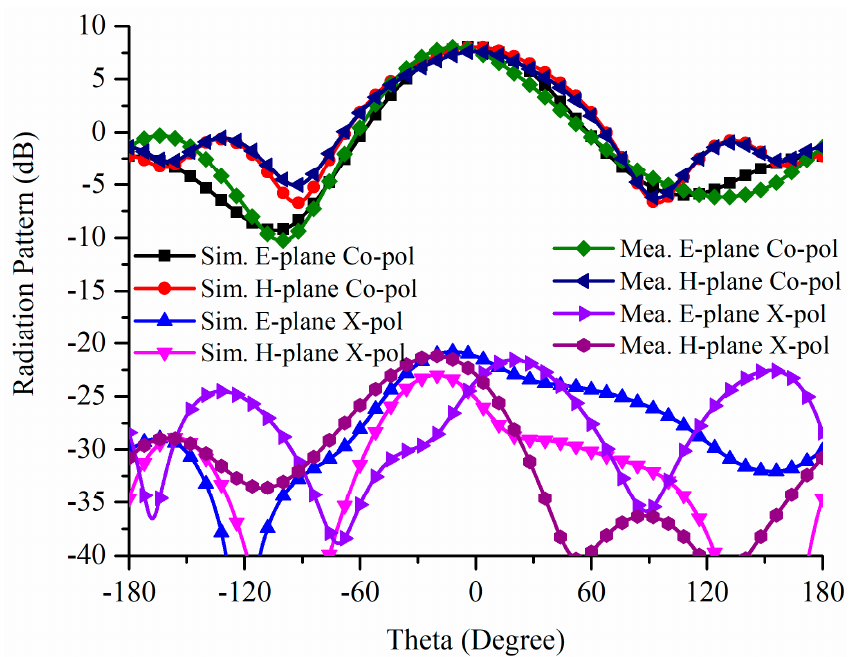
Figure 14. Simulated and measured radiation patterns at 5.85 GHz when Port 2 is excited.